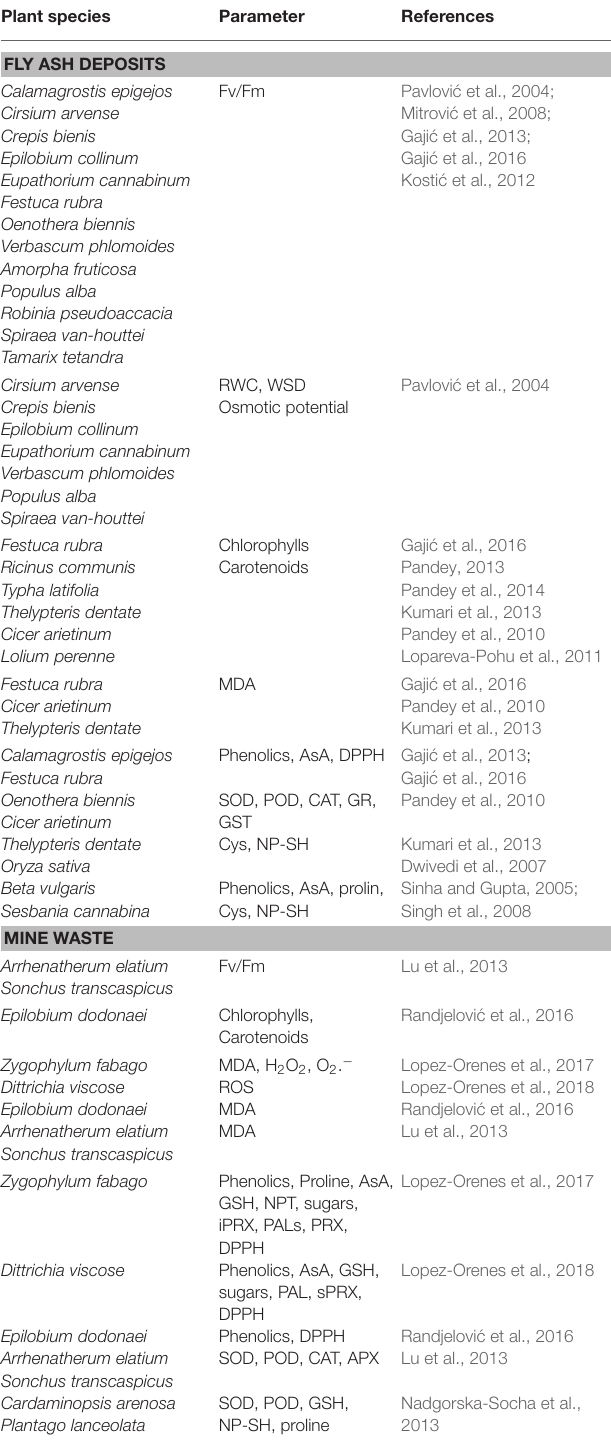
TABLE 4 | Adaptive physiology of plants growing on fly ash deposits and mine